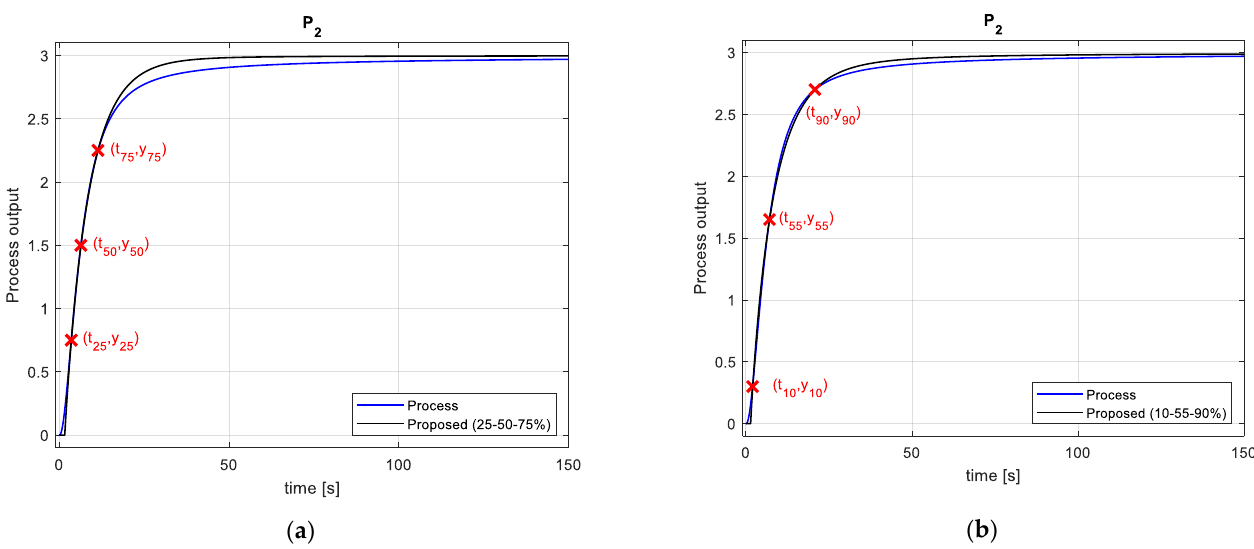
Figure 16. FFOPDT model step response using the proposed identification method for process P 2 and process reaction curve: ( a ) Symmetrical set of points (25-50-75%); ( b ) Asymmetrical set of points (10-55-90%).